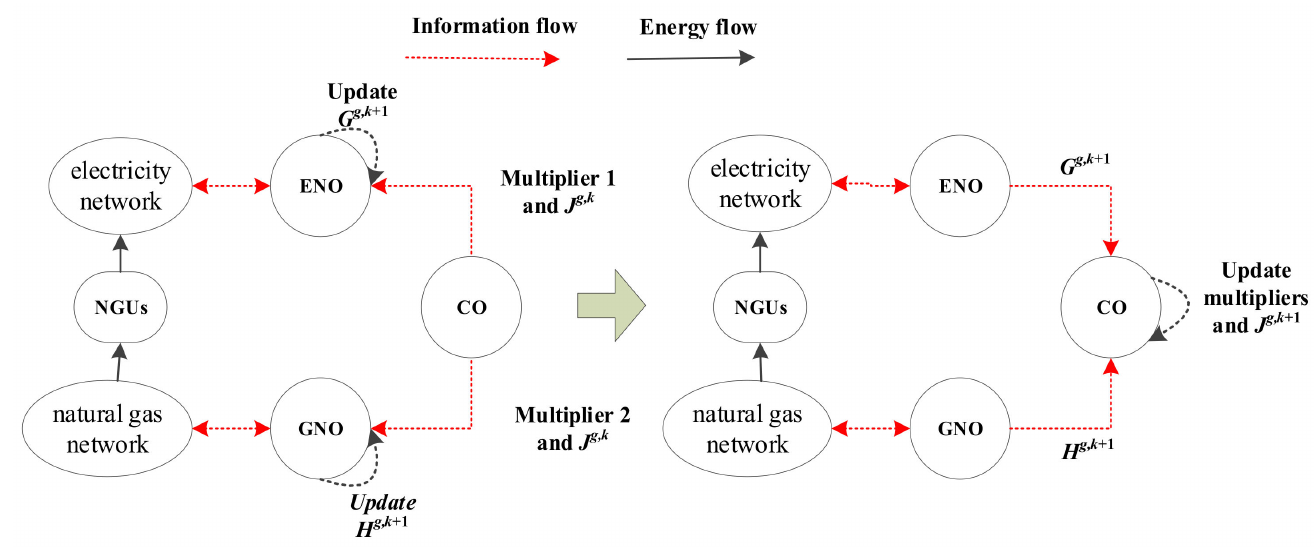
Figure 1. ADMM information flow with coordination